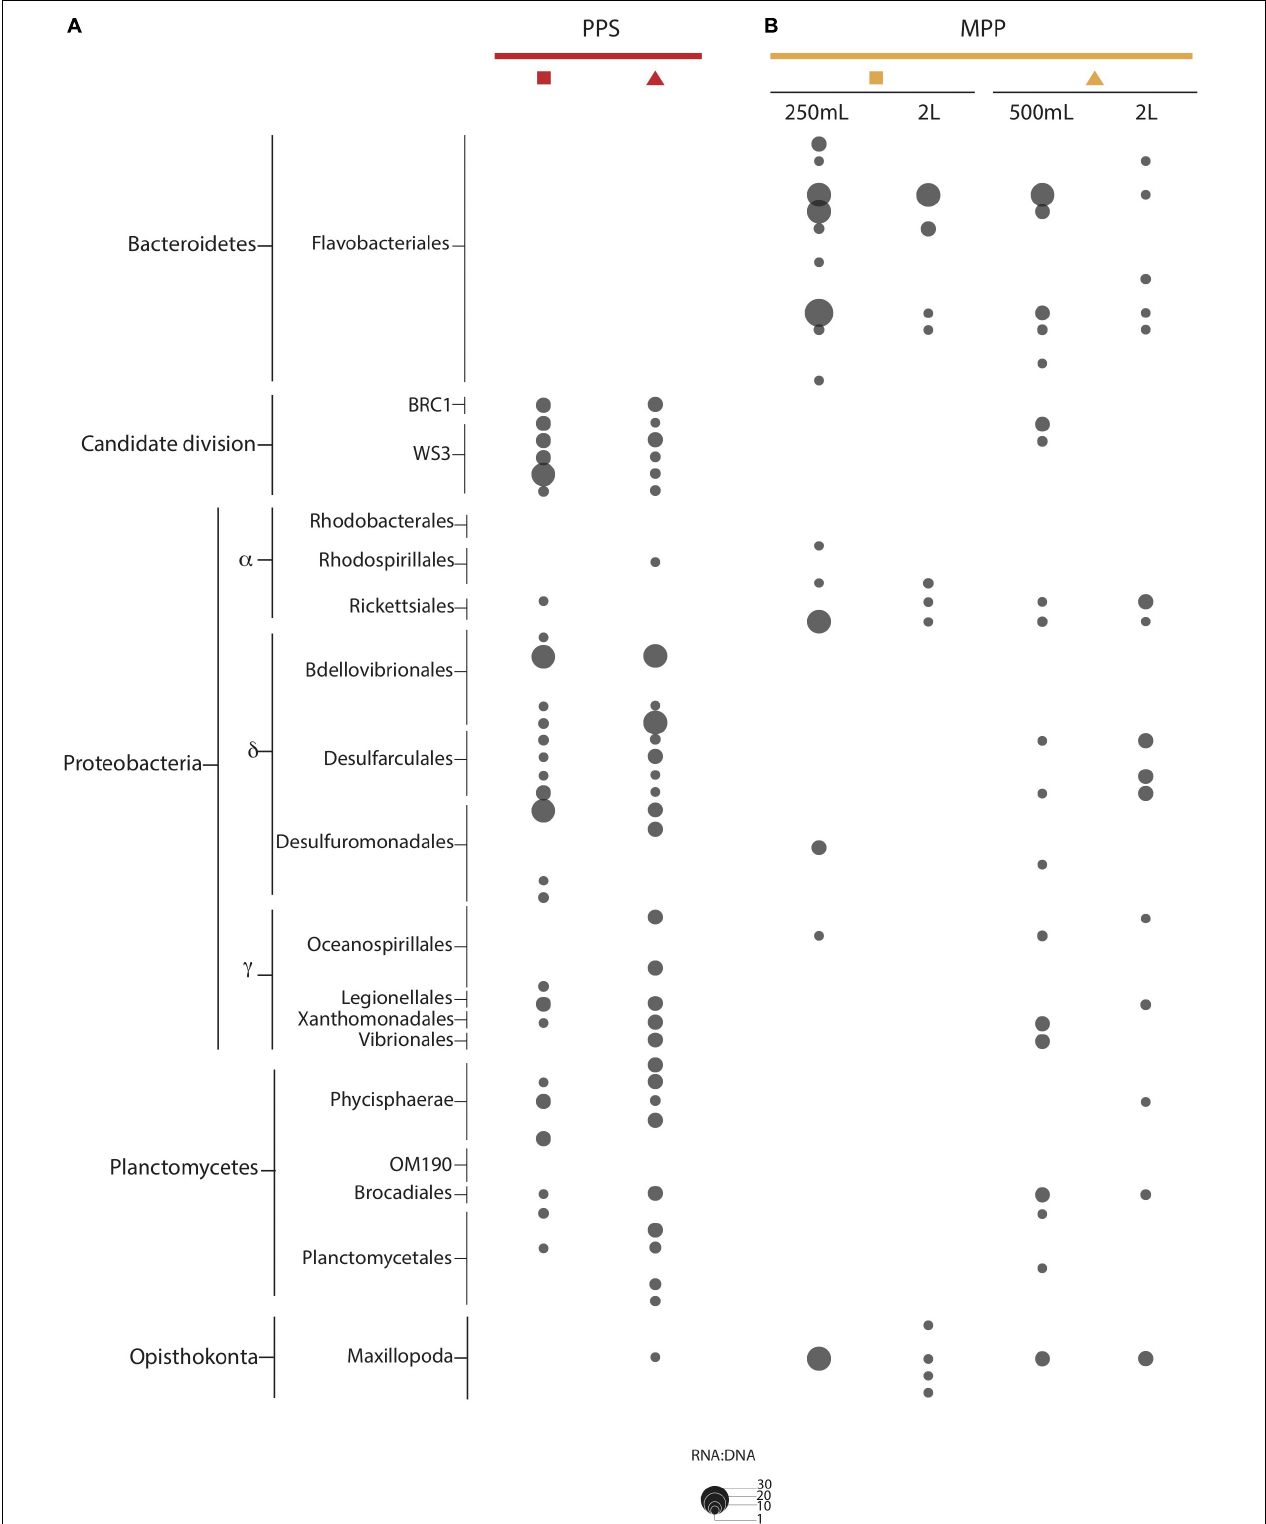
FIGURE 7 | RNA:DNA ratio for indicator OTUs observed at PPS in situ 0.4 µ m ( A : red) and MPP on-ship 0.22 µ m with in-line 0.4 µ m prefilters ( B : yellow). The size of dots depicts ratio values for individual OTUs as indicated on plot size key.